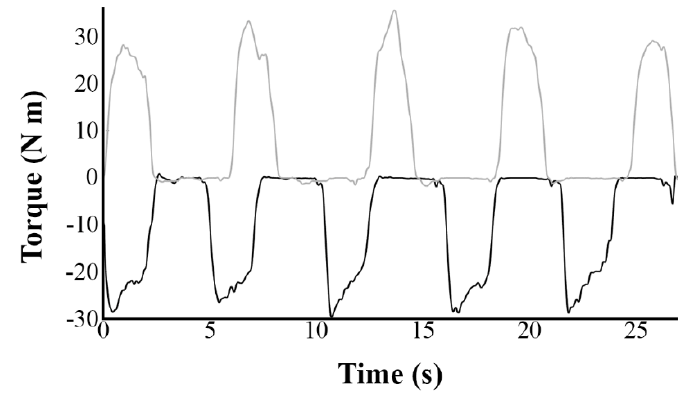
Figure 2. Representative recordings of torque values over five complete eccentric (black line) and concentric (grey line) movements for one participant. Anisometric contractions were performed at a constant angular velocity of 30°/s from time 0.